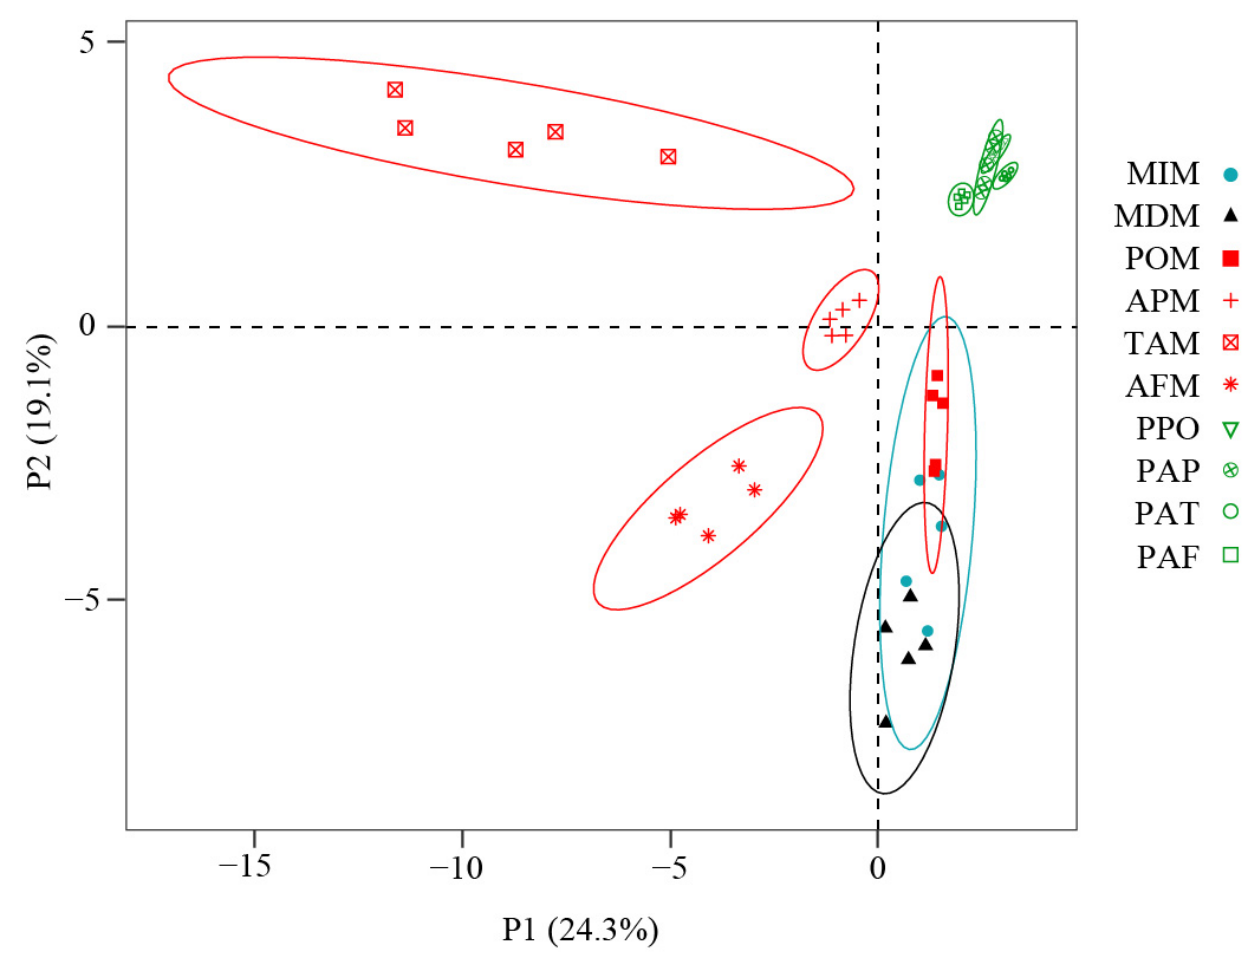
Figure 4. Partial least squares discriminant analysis (PLS-DA) of maize ears’ VOCs. MIM: mock- inoculated maize ears; MDM: mechanically damaged maize ears; POM: P. oxalicum -infected maize ears; TAM: T. asperellum -infected maize ears; APM: A. phoenicis -infected maize ears; AFM: A . flavus - infected maize ears; PPO: P. oxalicum growing in PDA medium; PTA: T. asperellum growing in PDA medium; PAP: A. phoenicis growing in PDA medium; PAF: A . flavus growing in PDA medium. P1 and P2: the first two significant PLS components.